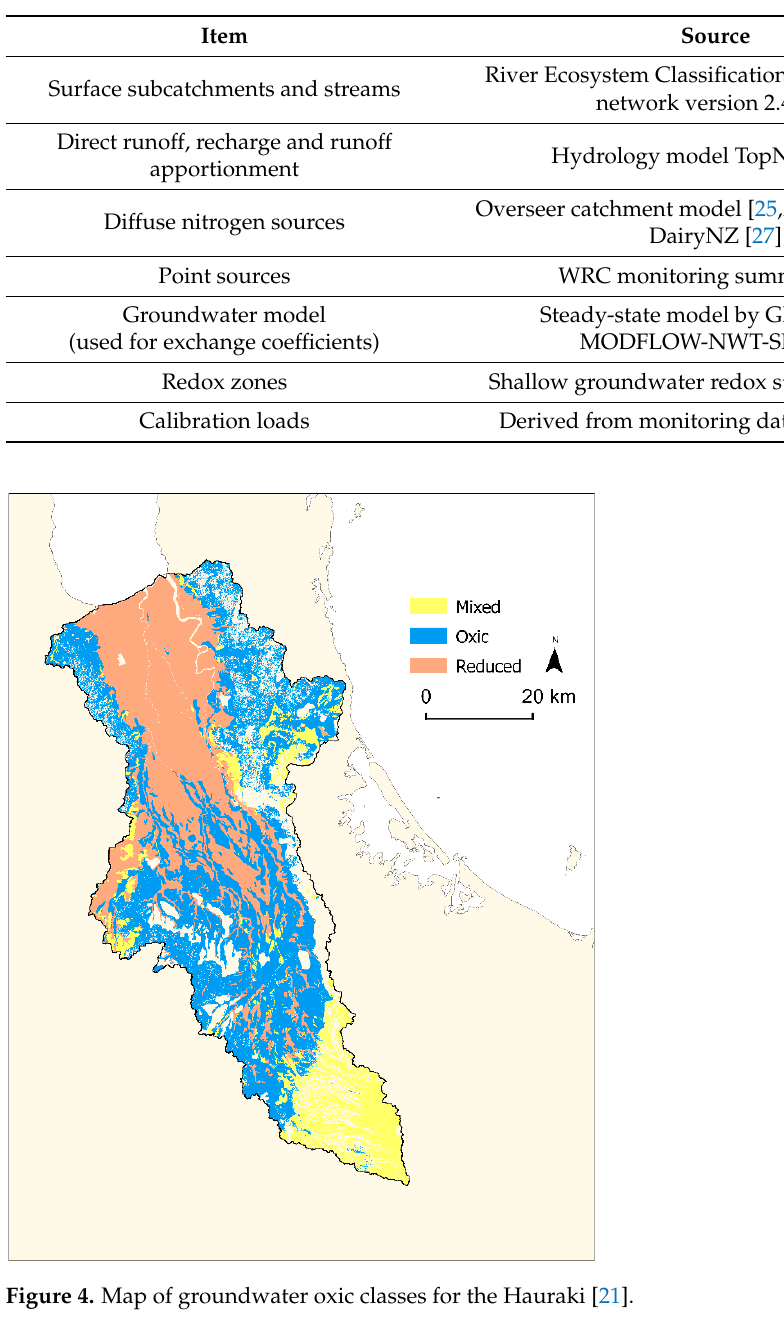
Table 1. Key data sources used for the Hauraki case study.